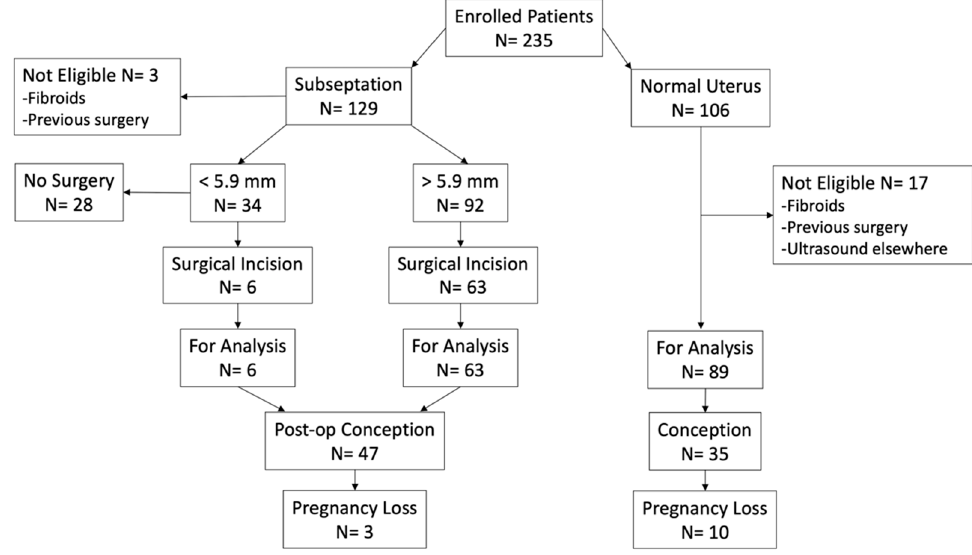
Figure 2. Flow diagram of the study participants and their reproductive outcomes.